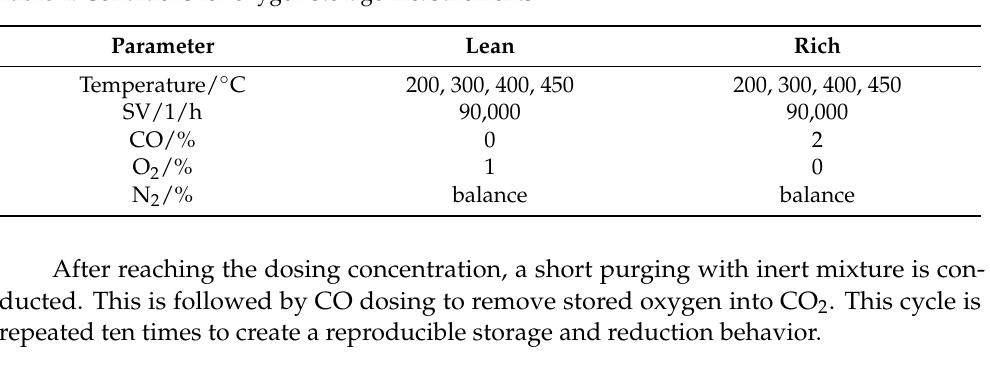
Table 4. Conditions for oxygen storage